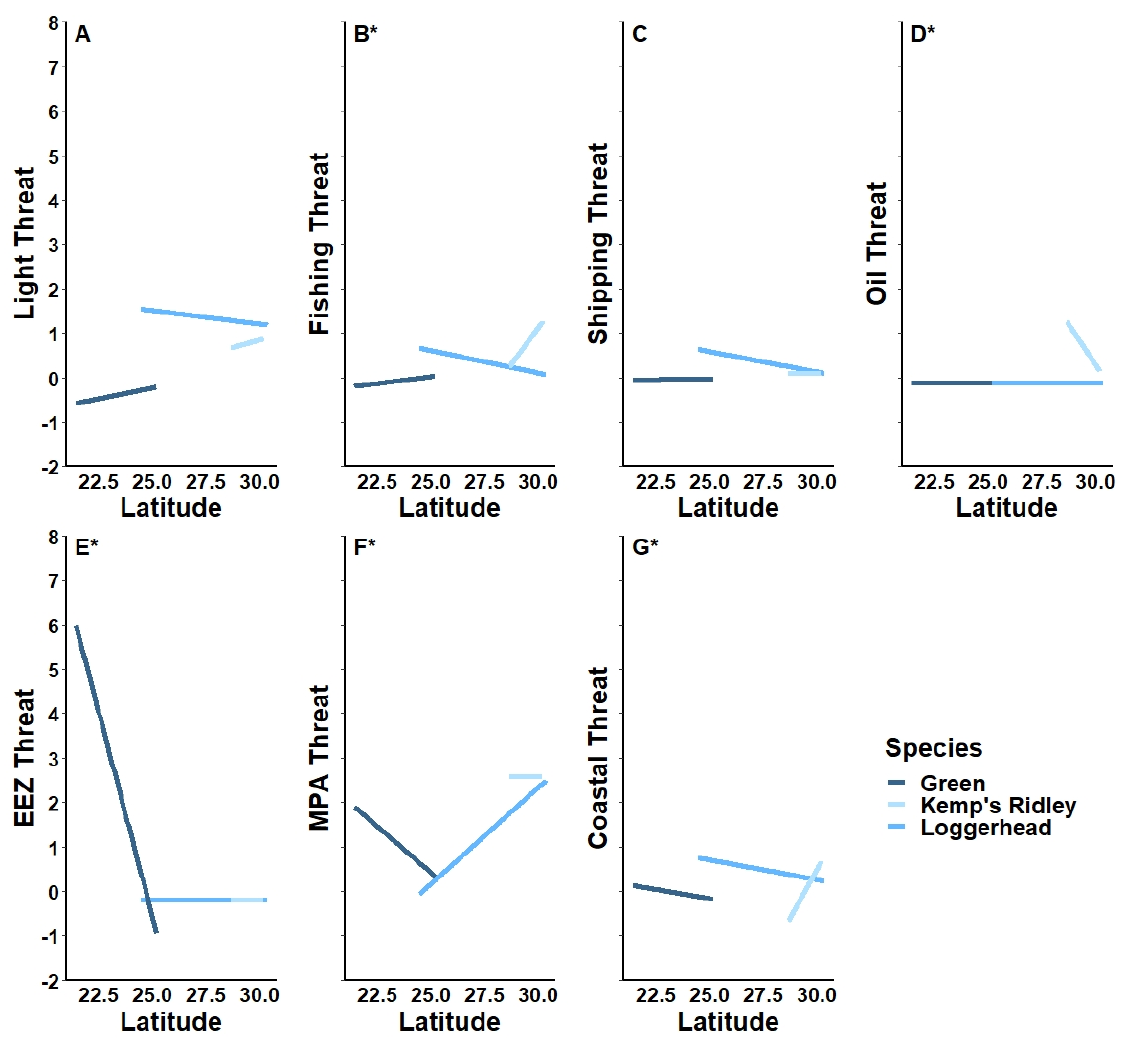
Figure 5. Interactive effects plot of latitude x species by the total score of all individual threats using standardized values. Standardizing threat scores reassigns values based on a mean of zero and standard deviation of one. Results from our PERMANOVA analysis found significant relationships between the interactive effects of latitude and species for five threats ( Fishing ( B ) F 2,448 = 9.499, p = 0.006, Oil ( D )—F 2,448 = 5.116, p = 0.012, Exclusive Economic Zone ( EEZ ) ( E )—F 2,448 = 672.42, p = 0.001, Marine Protected Area ( MPA ) ( F ) F 2,448 = 77.430, p = 0.001, and Coastal ( G ) F 2,448 = 10.236, p = 0.001). We found significant relationships on individual predictor variables and threat for both Light Pollution ( A ) (latitude—F 1,452 = 67.008 p = 0.001, species—F 2,451 = 21.142 p = 0.001) and Shipping ( C ) (species—F 2,451 = 7.431 p = 0.001) threats. Asterisks (*) next to each embedded figure letter denote a significant result.